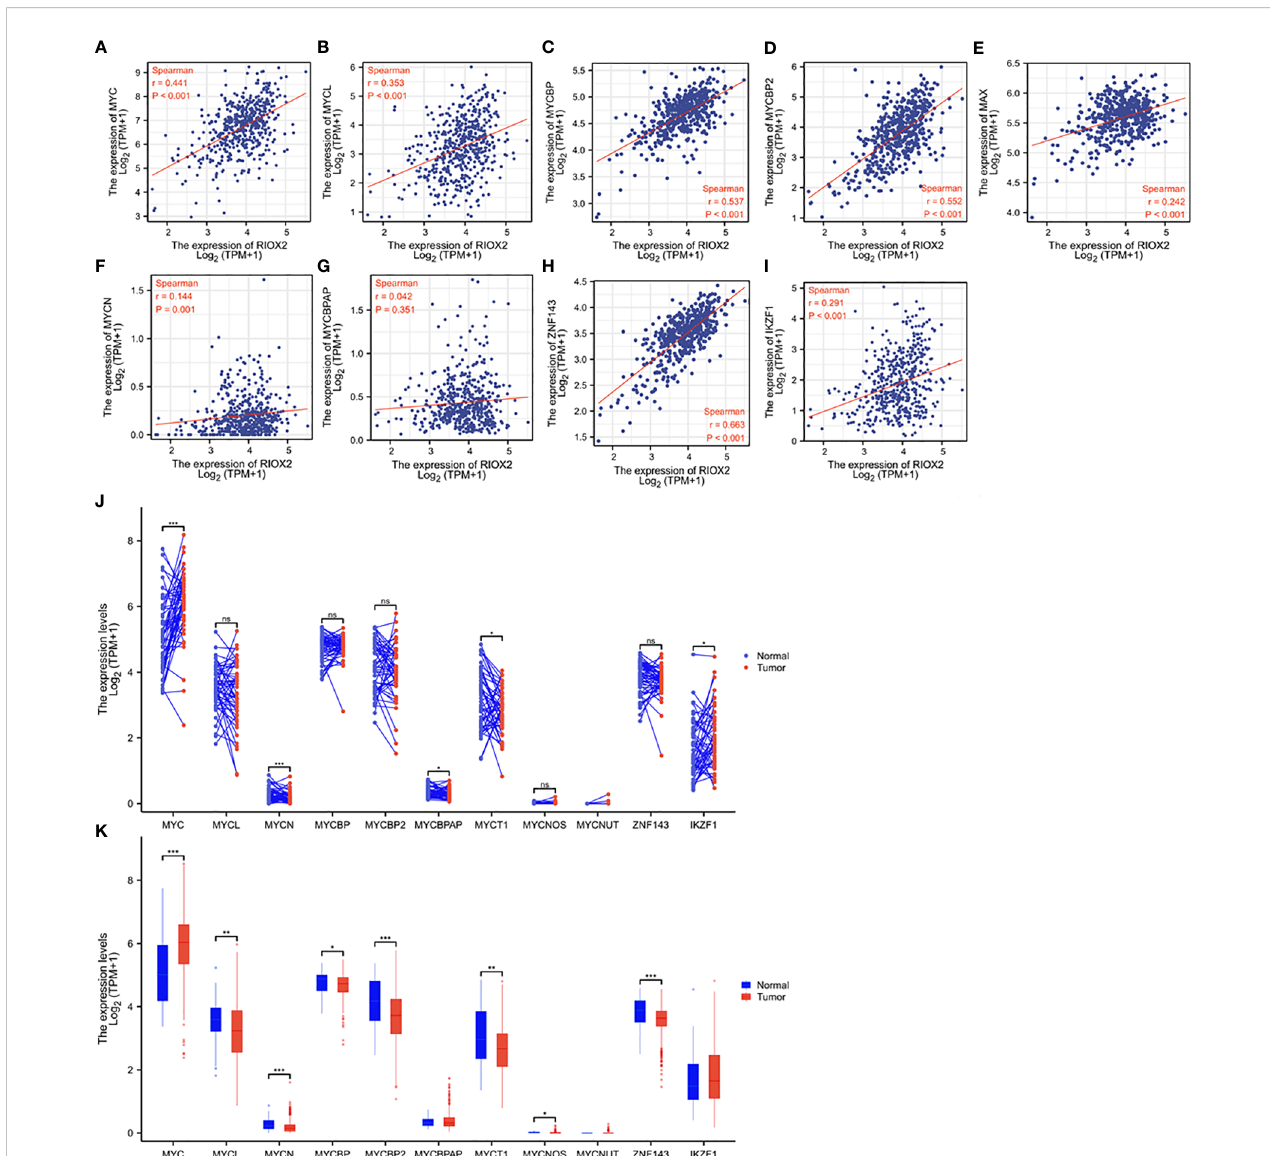
FIGURE 6 RIOX2 expression is correlated with MYC family genes in prostate cancer. (A – I) Spearman correlation analysis was conducted between RIOX2 and MYC family genes using the TCGA-PRAD RNA-seq dataset. Spearman r > +/- 0.3 was considered a strong correlation. (J, K) Gene expression levels of MYC family genes were extracted from the TCGA-PRAD RNA-seq dataset. Two types of comparison were conducted, case-matched pairwise (J) and group cohort (panel K) comparisons. The asterisk indicates a signi fi cant difference compared to the normal group (*p < 0.05, **p < 0.01, ***p < 0.001). ns, no signi fi cance. Case numbers: Normal tissues, 52; Tumors,